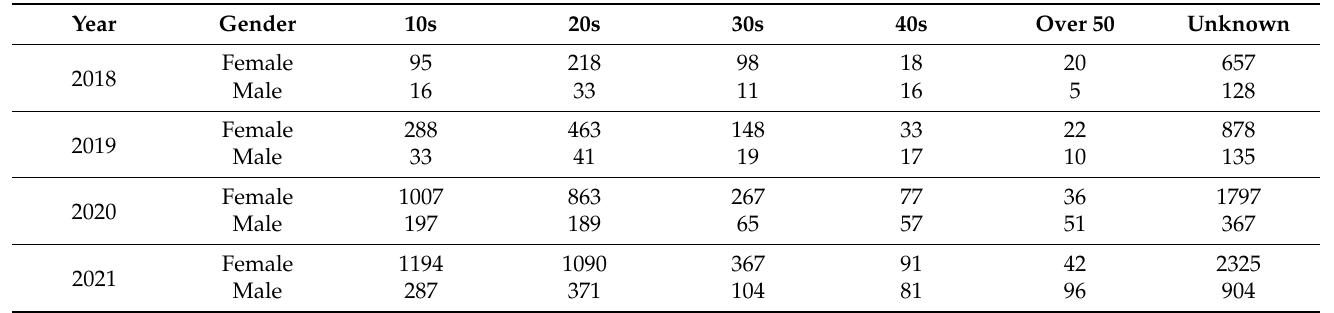
Table 2. Status of Victims by Year and Age.